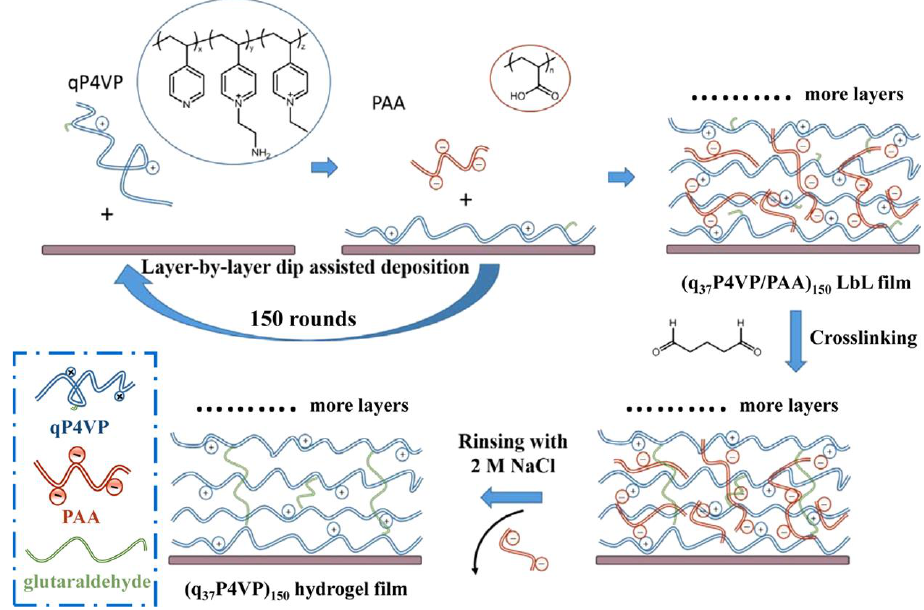
Figure 11. Fabrication of a q 37 P4VP hydrogel coating. Adopted from [91]. Under a Creative Com- mons license.